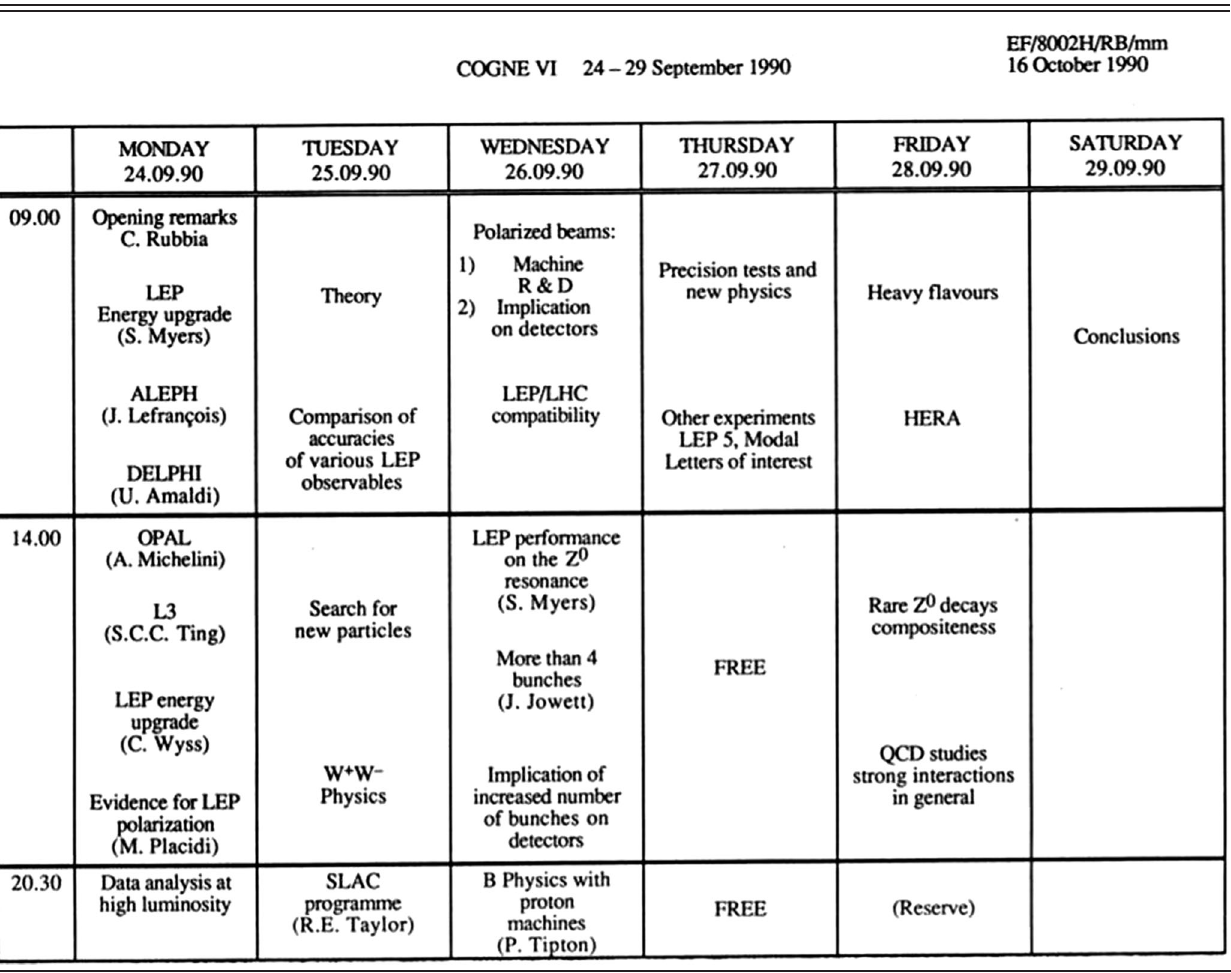
IPAC2010 ACCELERATOR PRIZE ARTICLE: TABLE IV. Discussion program for future of the LEP collider.